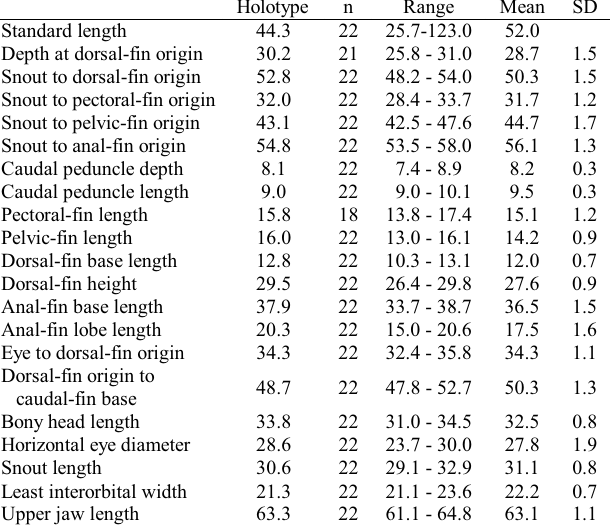
Table 1. Morphometrics of Galeocharax goeldii .